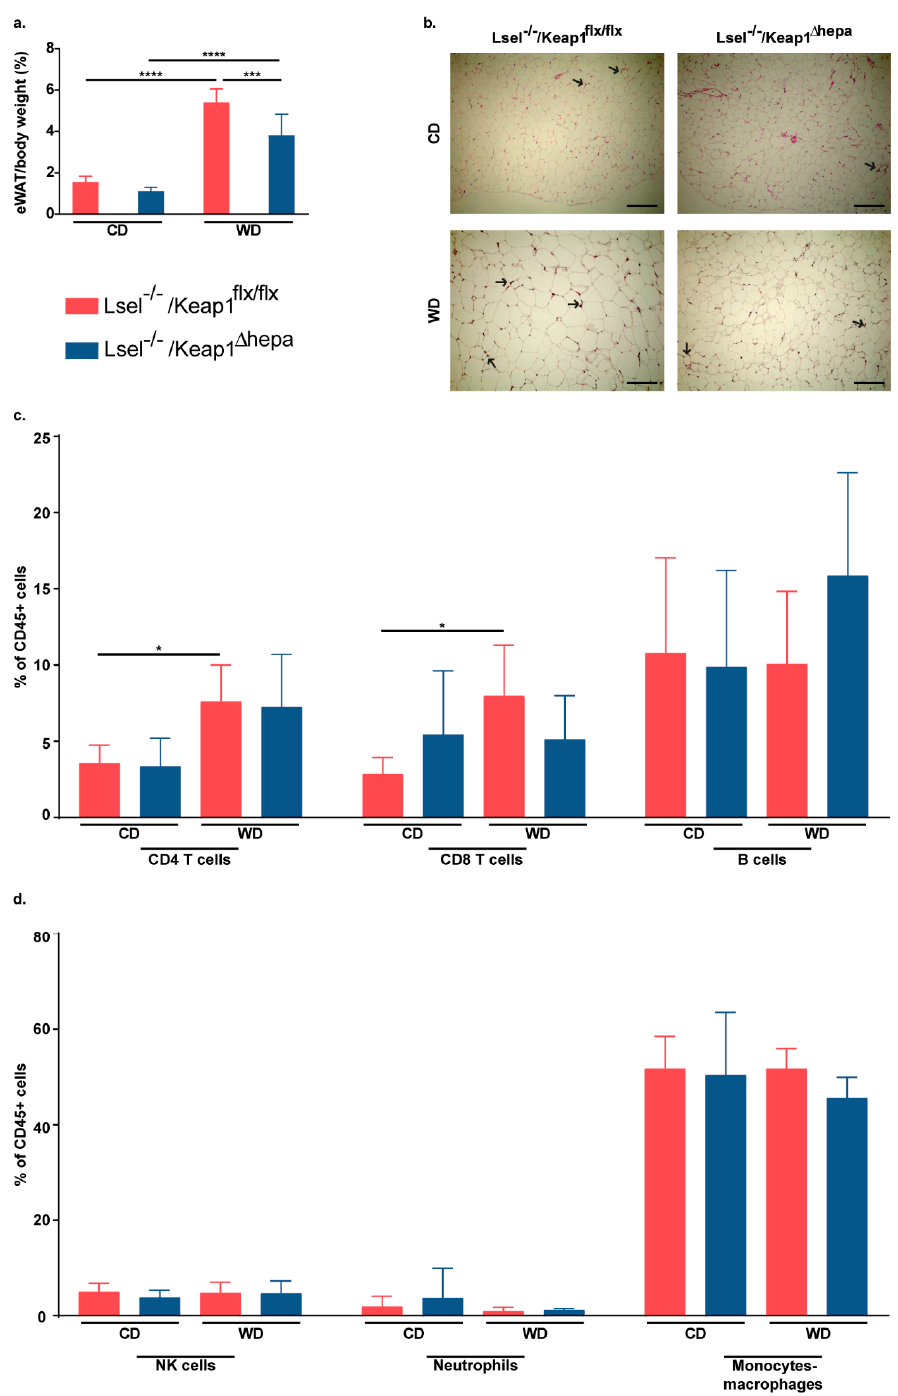
Figure 4. Epidydimal white adipose tissue of WD-fed Lsel − / − Keap ∆ hepa mice exhibit decreased immune cell infiltration. Lsel − / − Keap1 flx/flx mice (shown in red) and Lsel − / − Keap1 Δ hepa mice (shown in blue) were fed for 24 weeks on chow diet (CD) or Western diet (WD). Depicted are the endpoint values of Lsel − / − Keap1 flx/flx CD-fed (n = 6), Lsel − / − Keap1 flx/flx WD-fed (n =